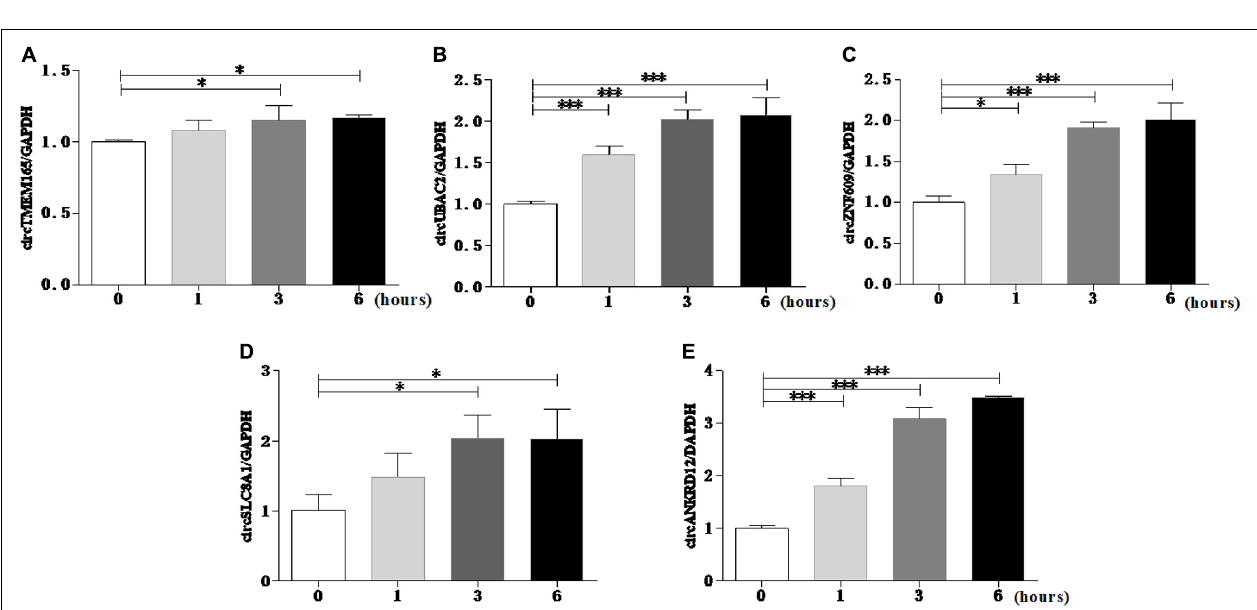
FIGURE 4 | Reconrmation of differentially expressed circRNAs in cell model. Myocardial cell injury model was used to simulate cell damage during MI, and the expression level of circTMEM165 (A) , circUBAC2 (B) , circZNF609 (C) , circSLC8A1 (D) , circANKRD12 (E) were analyzed by RT-qPCR ( ∗ P < 0.05, ∗∗∗ P < 0.0001).